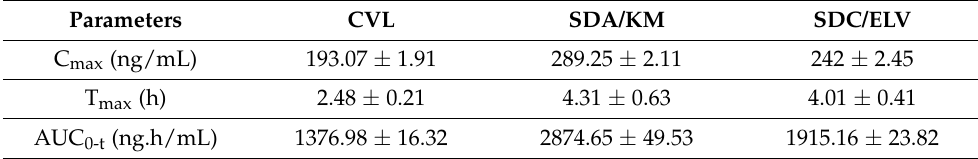
Table 2. The in vivo pharmacokinetic parameters of CVL-SDs after oral administration ( n = 6). Parameters